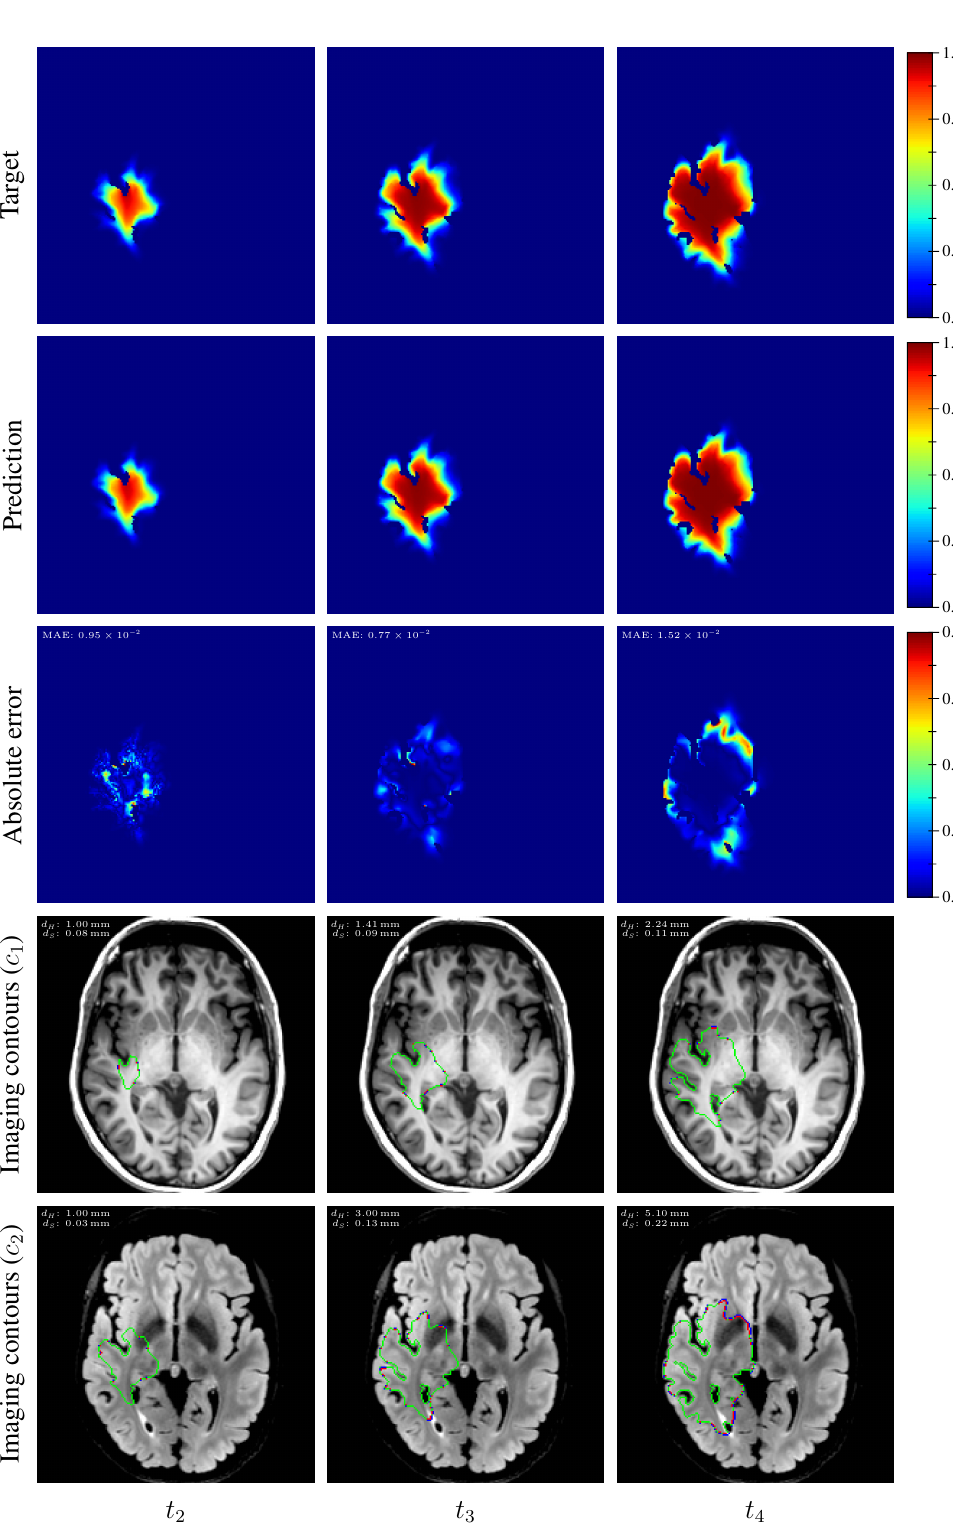
Figure 9. Example of true (1st row) and estimated (2nd row) three-dimensional tumor cell-density distributions at times t 2 − 4 (1st to 3rd column, axial slices) along with the corresponding absolute error maps (3rd row) for a test tumor ( d = 43.47mm 2 year − 1 , ρ = 11.22year − 1 , t 1 = 94d, t 2 = 264d). The imaging contours for threshold values c 1 = 0.80 and c 2 = 0.16 superimposed to the T1 and T2 FLAIR image are depicted in the 4th and 5th rows, respectively. The blue, red, and green segments respectively correspond to the target, prediction, and overlapping contour voxels. MAE: mean absolute error for c > 0.01, d H : Hausdorff distance, d S : average symmetric surface